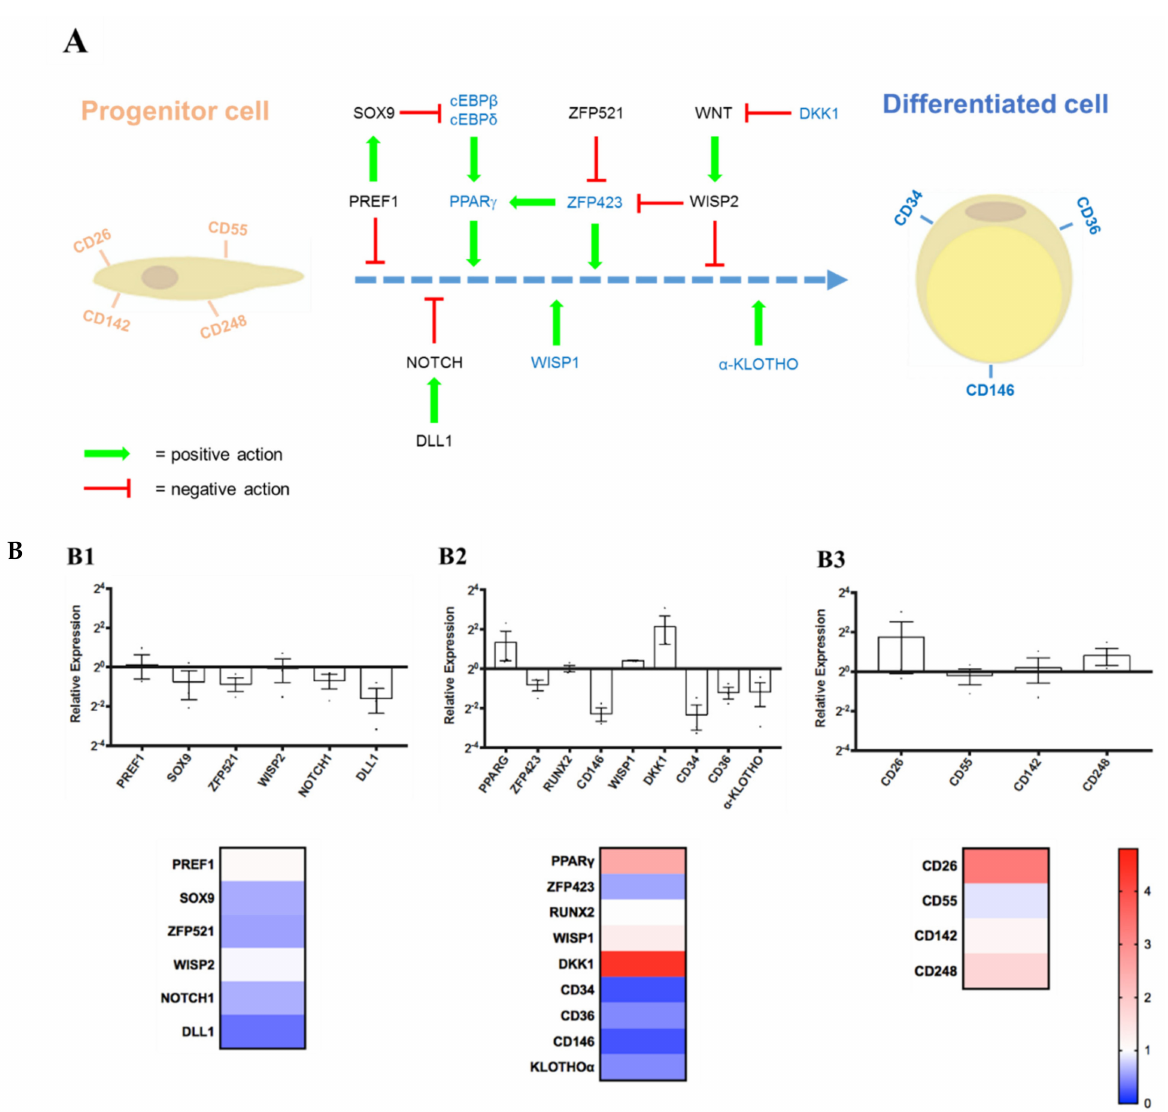
Figure 6. ( A ) Factors that positively or negatively regulate the adipocyte differentiation process. Different regulatory proteins act at early and later stages to control adipogenesis. ( B ) Expression levels measured by RT-qPCR of genes involved in cell stemness or cell differentiation: ( B1 ) stemness maintenance genes; ( B2 ) differentiation regulators/markers; and ( B3 ) lineage hierarchy markers. Primary hASCs from three different donors were analyzed at passages P0, P1, and P2. The three upper bar graphs show the relative fold-expression change of the different markers at P2 compared with hASCs at P0 (n = 3, error bars represent S.E.M.). The three lower figures represent the same data as the heatmap for the three different